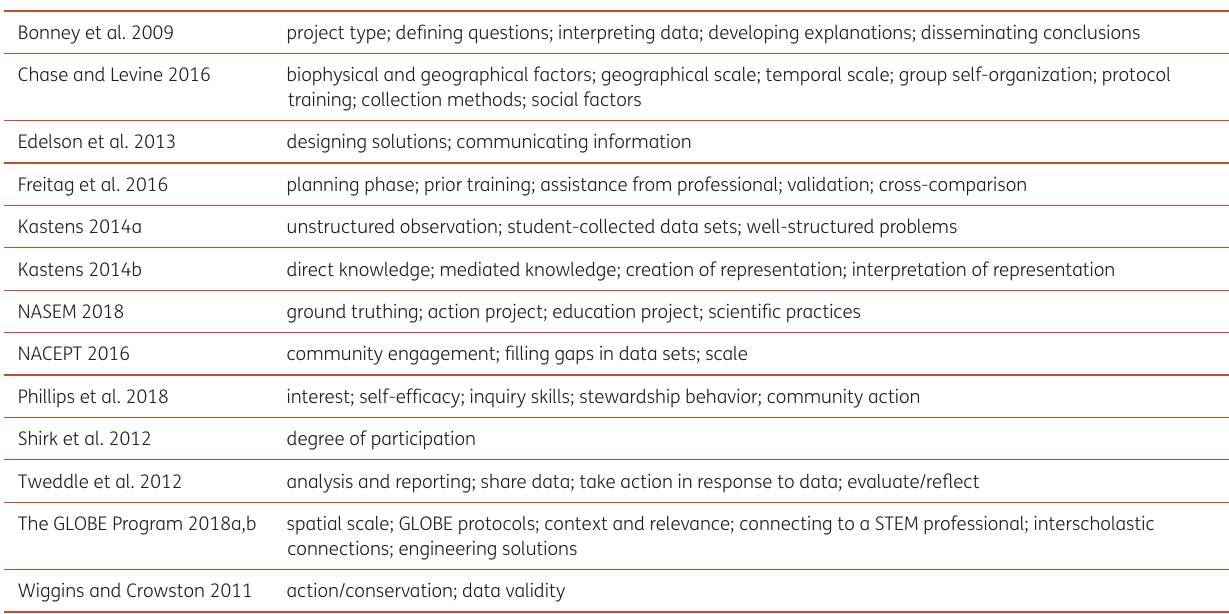
Table 2 Literature sources for GLOBE investigation